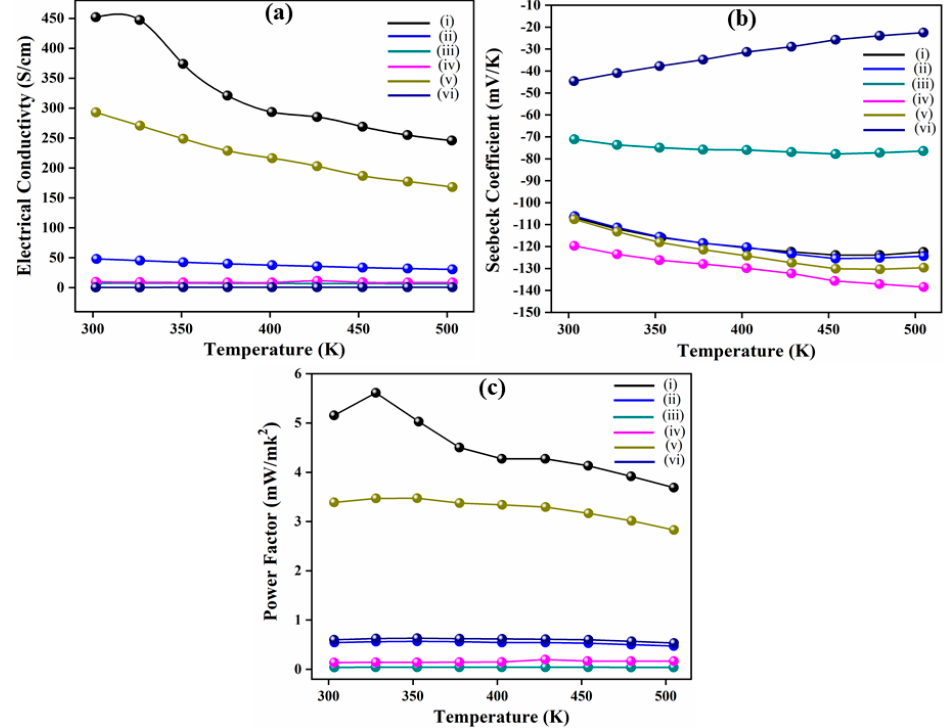
Figure 5. ( a ) σ , ( b ) S , and ( c ) PF, of the co-doped n-type BT sample, where (i) CeBTSn, (ii)